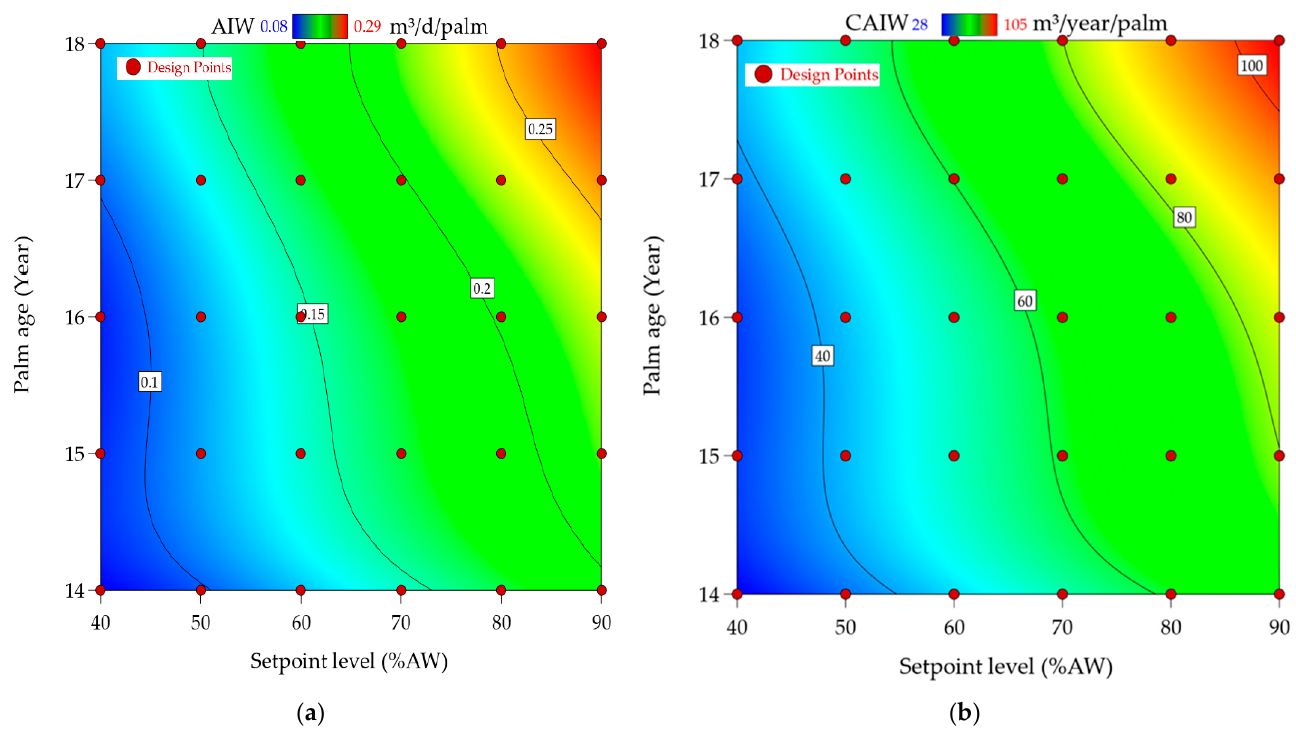
Figure 6. Amount of daily applied irrigation water (AIW) per date palm tree ( a ) and cumulative yearly applied irrigation water (CAIW) per date palm tree ( b ) at different minimum irrigation control setpoints (%AW) and date palm ages during the experiment years from 2018 to 2022.